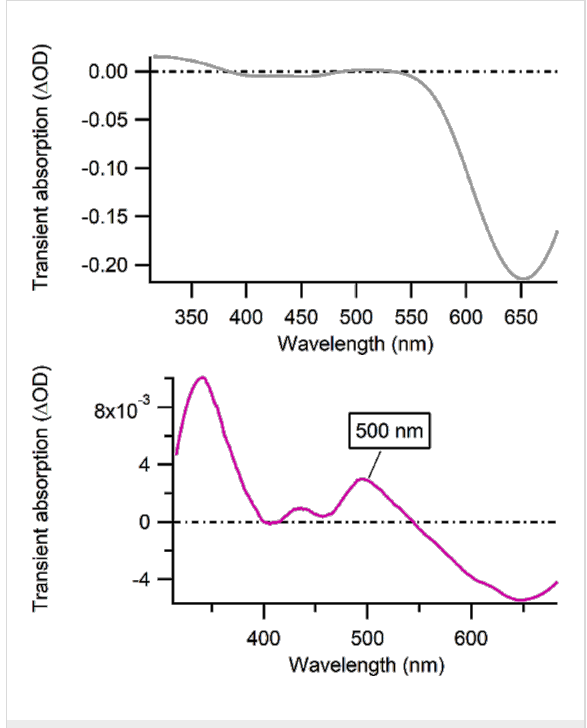
Figure 5: Transient absorption spectra of Ru II -calix[4]arene- [c-(RGDfK)] 4 conjugate 9 (in 10 mM Tris·HCl buffer at pH 7.0) measured 500 ns after the laser pulse (gray, top) and 1 µs after the laser pulse in the presence of 10 mM GMP (purple,